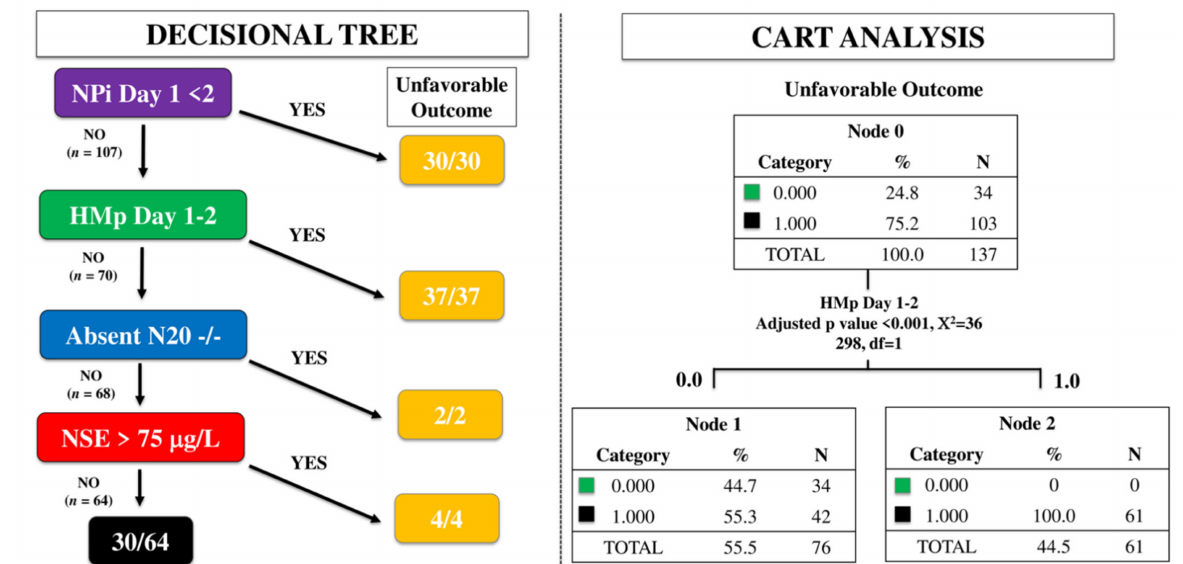
Figure 1. Time-dependent decision tree (left) and classification and regression tree (CART) analysis (right) to assess the prognostic accuracy of a multimodal approach. NPi, neurological pupil index; HMp, highly malignant patterns on the EEG; N20, cortical response on somato-sensory evoked potentials testing; NSE, neuron specific enolase.